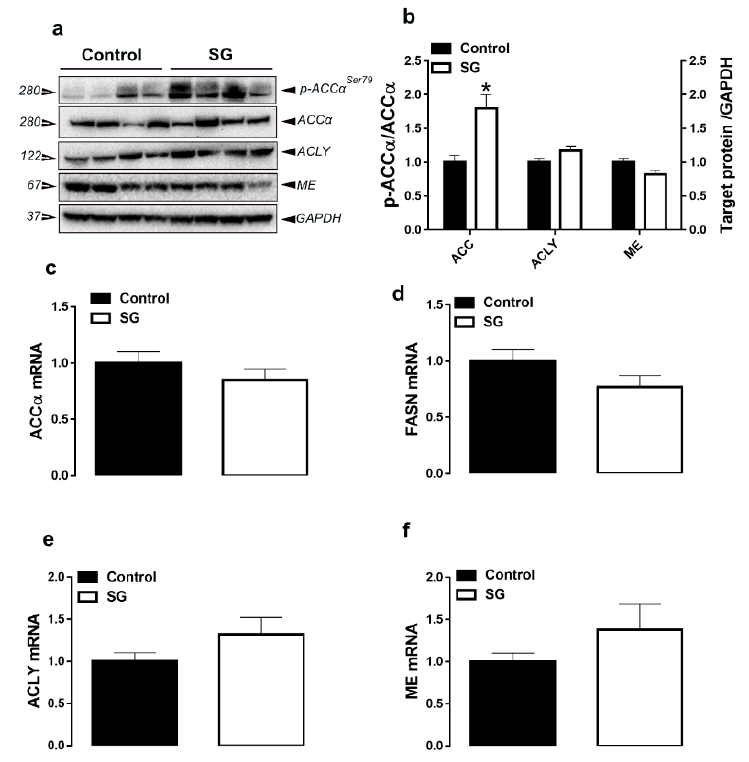
Figure 2. Effect of the phytogenic water additive SG on the expression of lipogenesis-related proteins in liver tissue. Protein levels ( a , b ) were measured by Western blot and mRNA abundances ( c – f ) were determined by qPCR using the 2 −∆∆ Ct method [21]. Data are presented as the mean ± SEM ( n = 8 birds/ group). * Denotes significant difference compared to the control group at p < 0.05. ACC α , phosphorylated-acetyl CoA carboxylase; ACLY, ATP citrate lyase; FASN, fatty acid synthase; ME, malic enzyme. Table 1. Effect of the phytogenic water additive AVSSL on lipid metabolism genes in the liver tissue a .